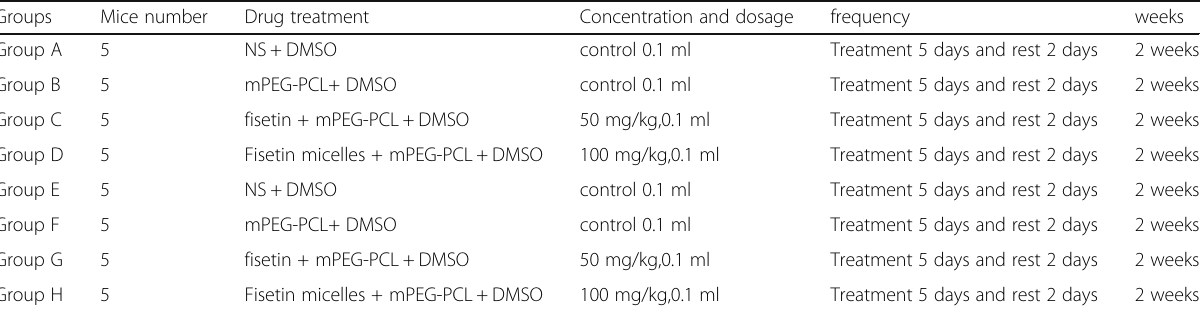
Table 1 Groups of Xenograft model of ovarian cancerand treatment